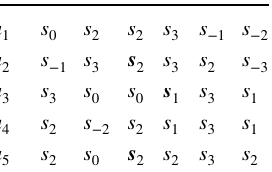
Table 6 FLC ( U , A , S , R )